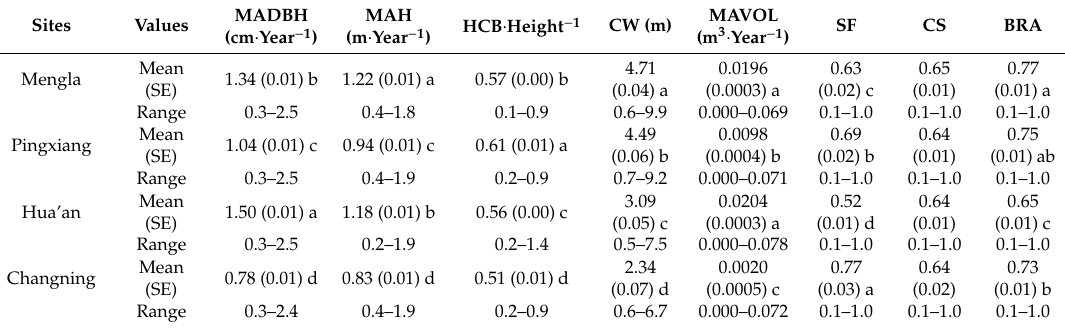
Table 2. Growth and quality performance of Betula alnoids at four trial